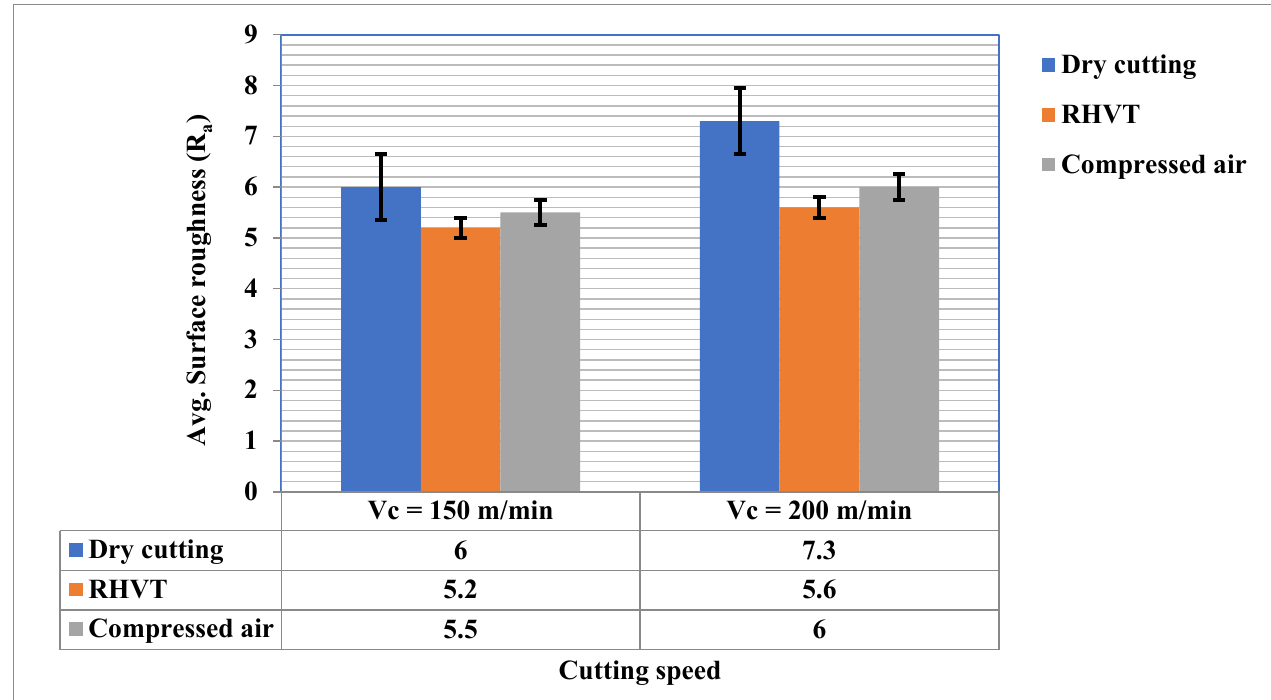
Figure 14. Avg. surface roughness parameter (Ra) for cutting speed 150 m/min and 200 m/min.